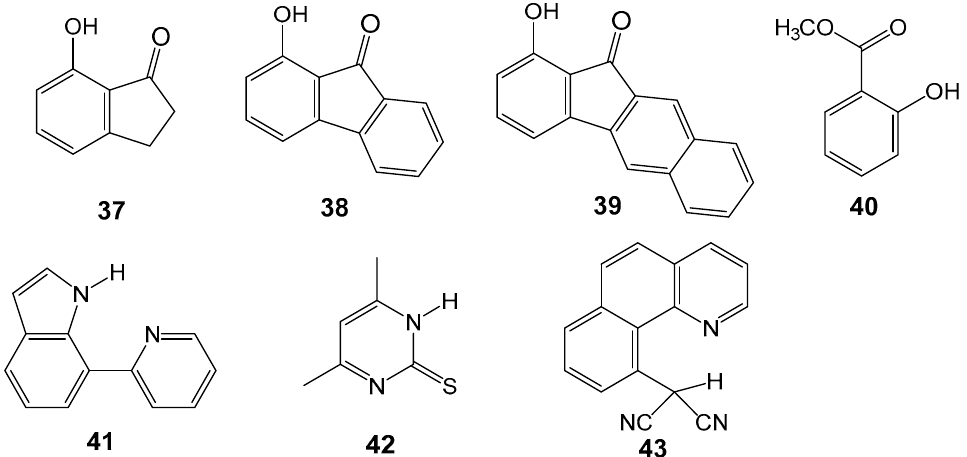
To further showcase the transferability of the linear regression models, we compared both the S 0 and S 1 polarizabilities for all systems in Scheme 3, as shown in Tables 5 and 6, respectively. Since Shannon entropy and Fisher information have exceptions for the linear regressions, they were not used for predicting the polarizabilities of all systems in Scheme 3. From Table 5, one can see that, S GBP , r R 2 , r R 3 , and G 3 perform well in reproducing the conventional S 0 polarizabilities, as evidenced by the mean unsigned errors (MUEs) and mean signed errors (MSEs). The other five quantities show reasonably good predictions. From Table 6, one can observe that the predicted S 1 polarizabilities are in reasonably good agreement with the conventional data. All the quantities show comparable perfor- mance. Taken together, we have shown that the transferability of the linear regression models is convincing, as the systems in Scheme 3 show little or low similarity to those in Schemes 1 and 2.